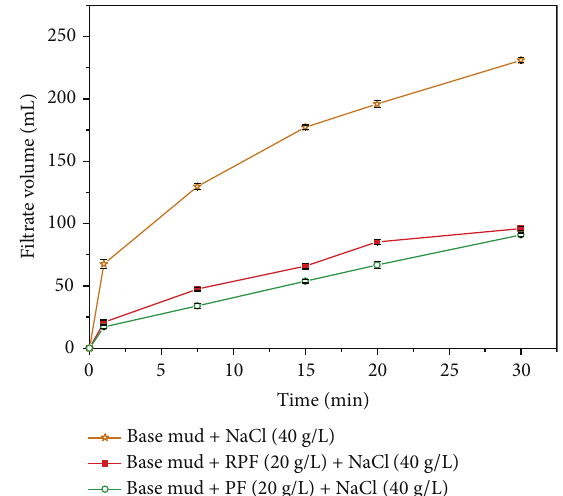
Figure11:HTHPfiltrationlossofRPFandPFinbasemudandNaCl (40g/L)